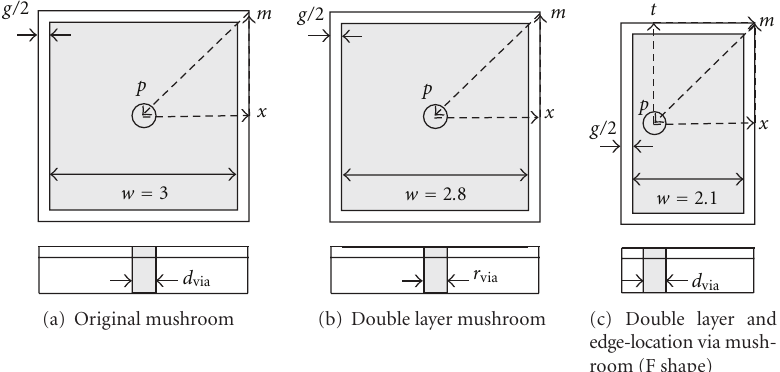
Figure 3: Unit cell scheme for eigenmode solutions.